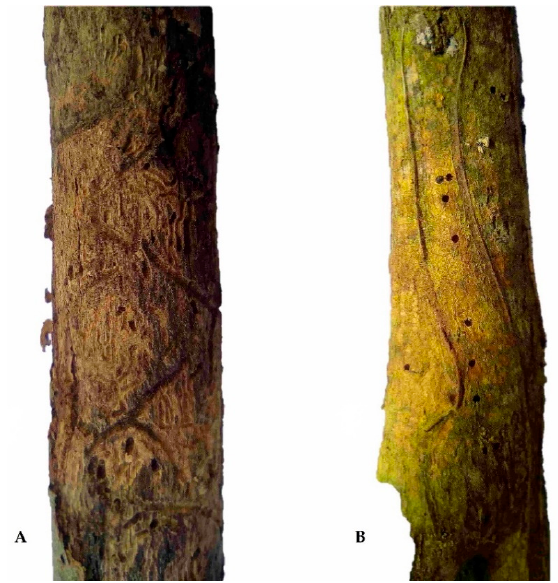
Figure 1. Galleries ( A ) and exit holes ( B ) of Phloeotribus rhododactylus.